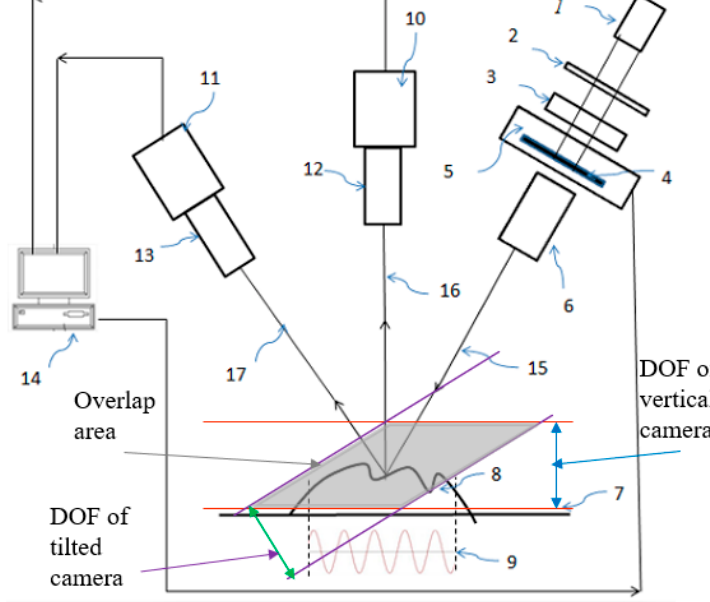
Figure 3. Configuration of the developed dual-sensing measurement system.